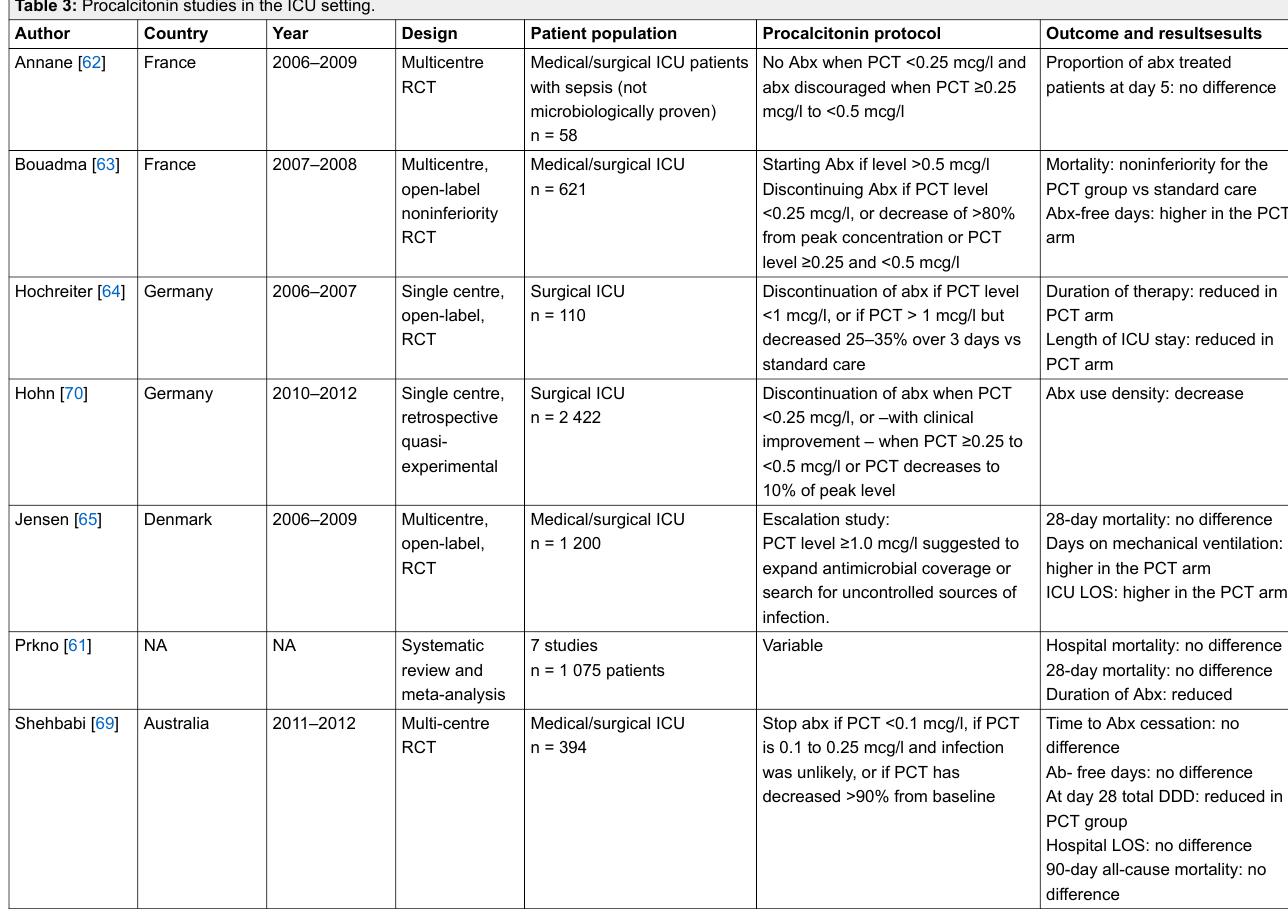
Mortality: noninferiority for the PCT group vs standard